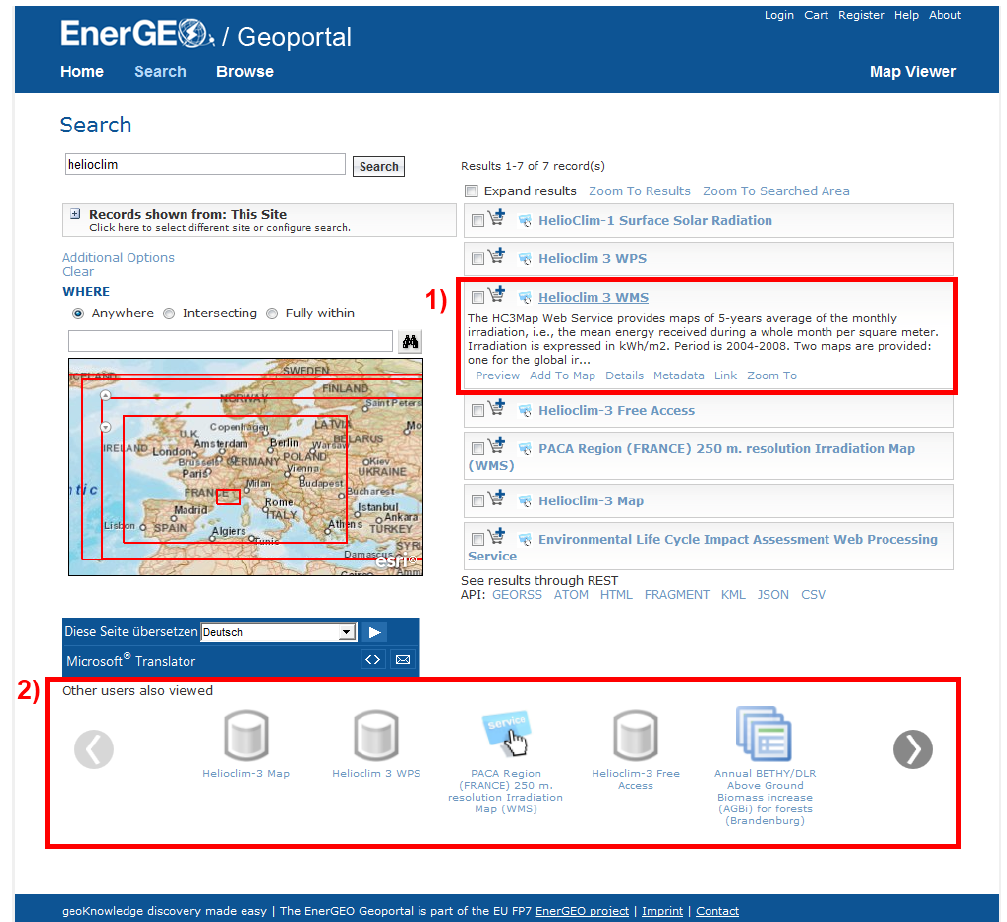
Figure 8. Recommender-enhanced discovery in the EnerGEO